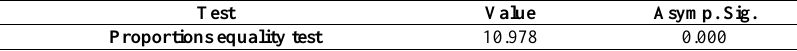
Table 9. Test of equality of proportions of non-prosperous companies among outliers and